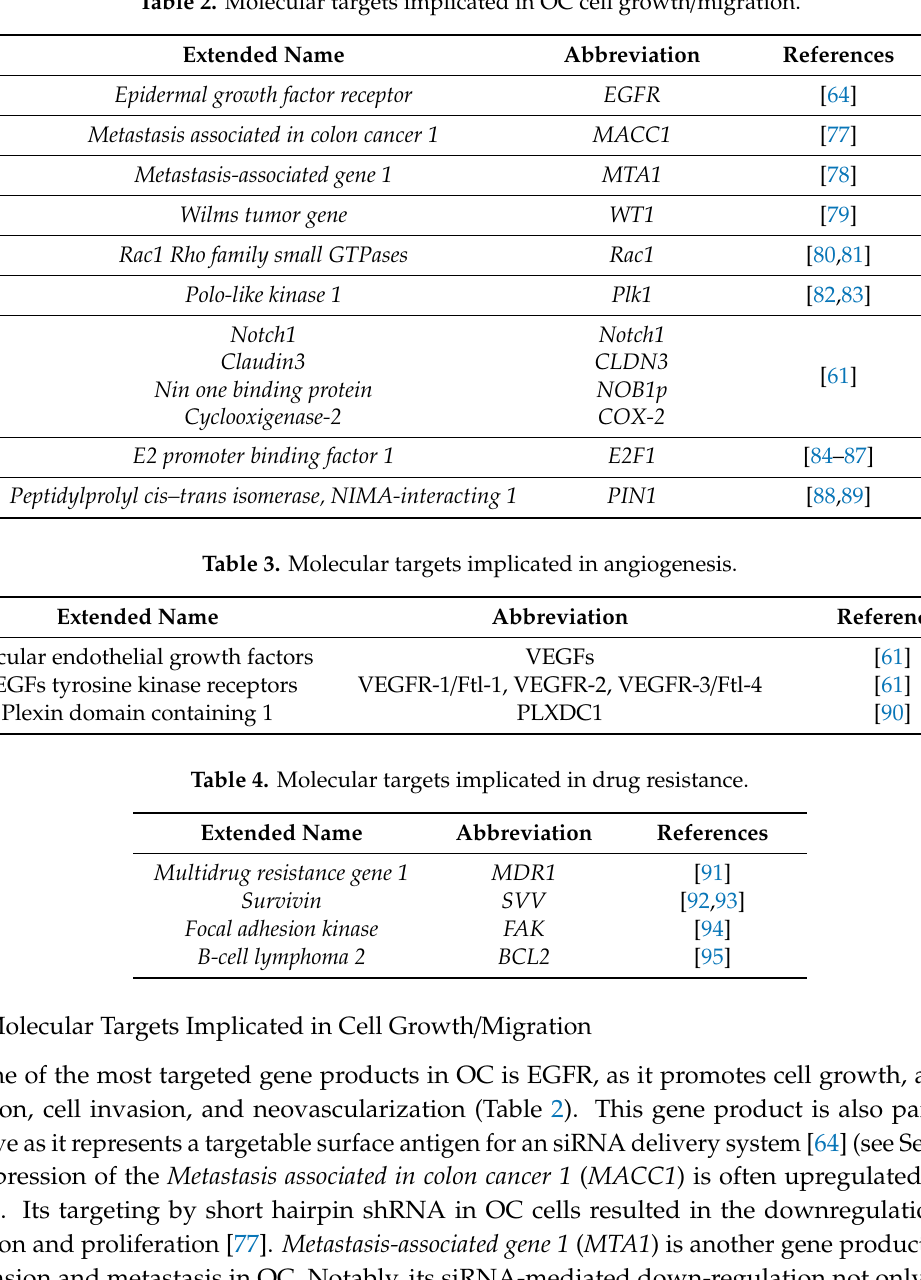
Table 2. Molecular targets implicated in OC cell growth / migration.